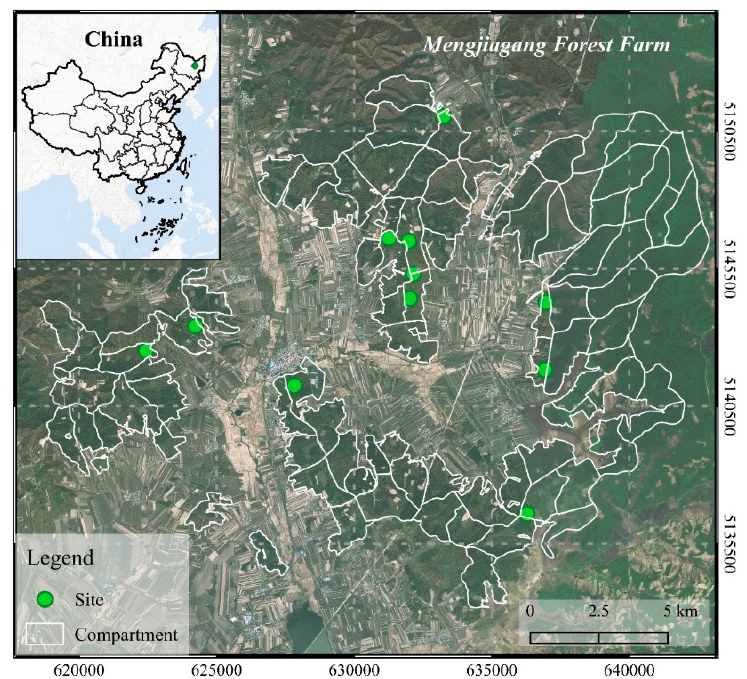
Table 1. Descriptive statistics of the field-measured data.